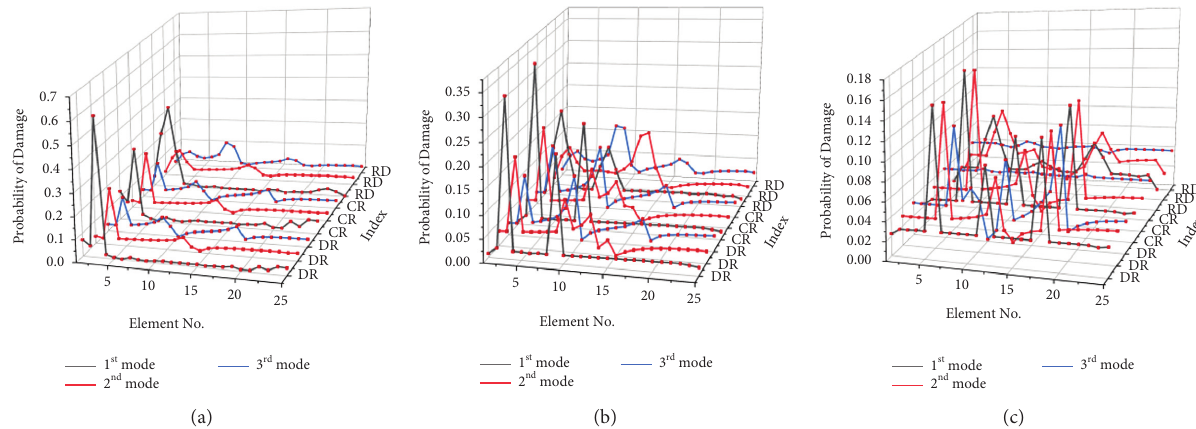
Figure 9: The identification results of single index for single (a), two (b), and three (c) damage cases. (a) Case 1. (b) Case 15. (c) Case 20.